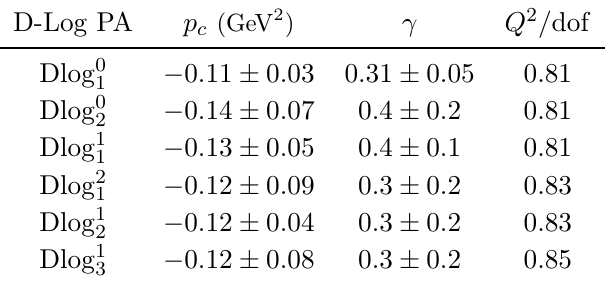
Table 7 . Branch point p c and the multiplicity γ , alongside the corresponding Q 2 / dof value, from fits of D-Log Padé approximants to the Landau-gauge ghost-propagator lattice data.